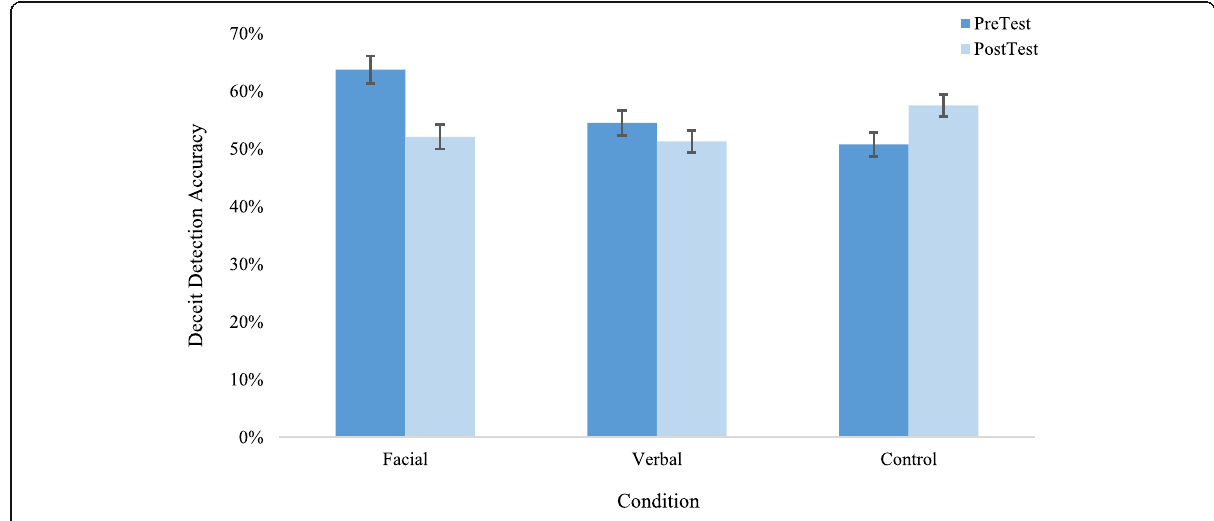
Fig. 2 Deceit detection accuracy by condition. Note, bars are standard error of the